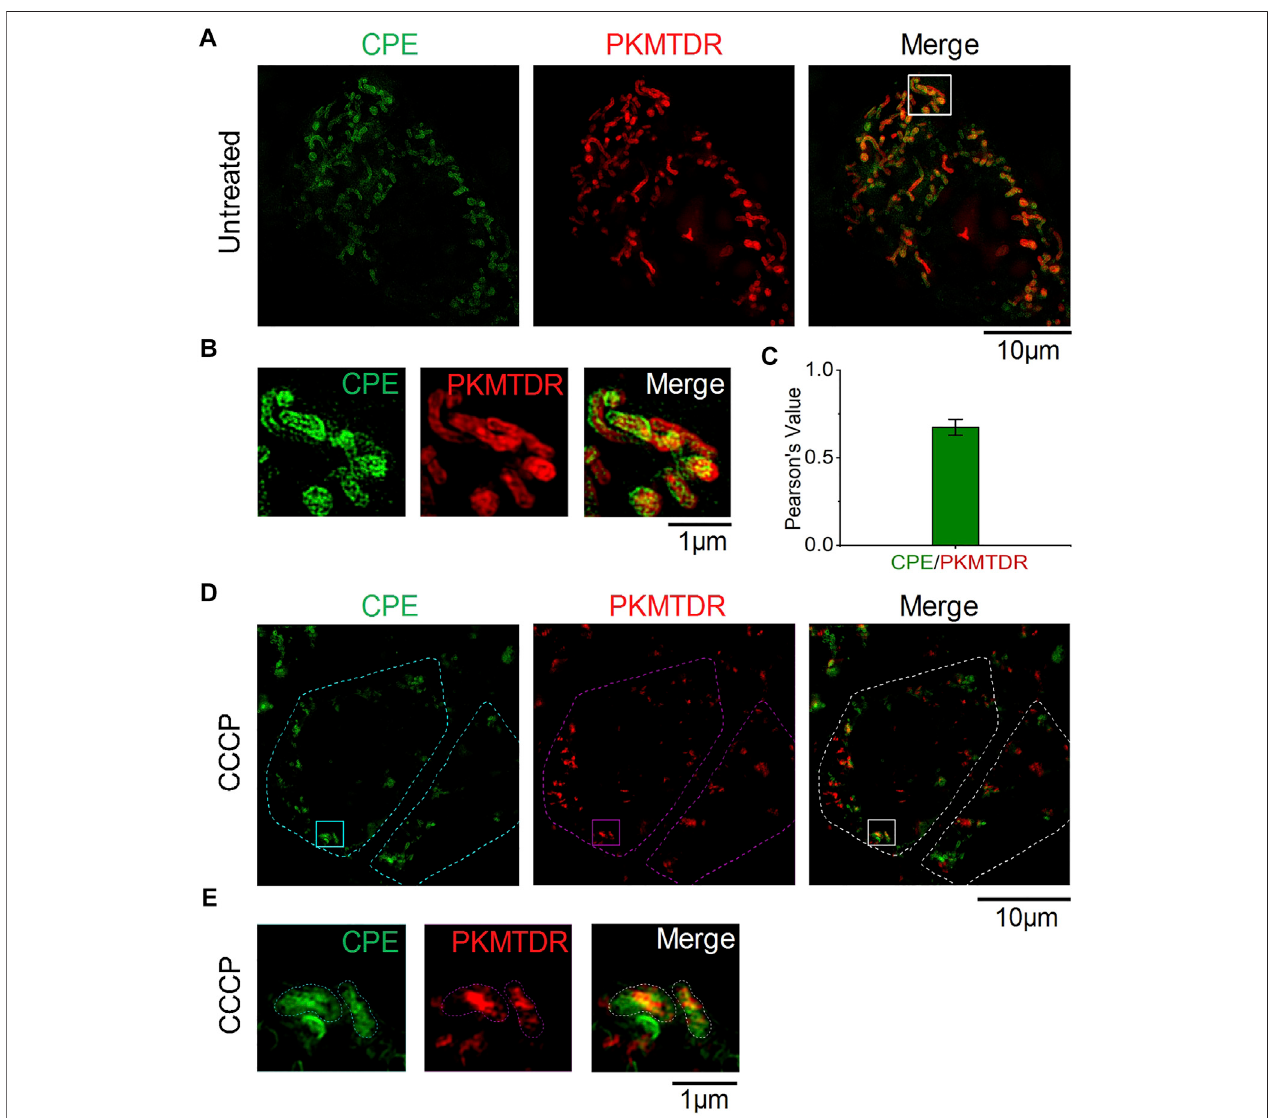
FIGURE 3 | Colocalization of CPE and PKMTDR in HeLa cells under SIM. (A) Merged SIM images of cells stained with CPE and PKMTDR. (B) Enlarged images of the indicated regions in (A) . (C) Quantitative analysis of the colocalization between CPE and PKMTDR. (D) CCCP-treated HeLa cells. (E) Enlarged images of the indicated regions in